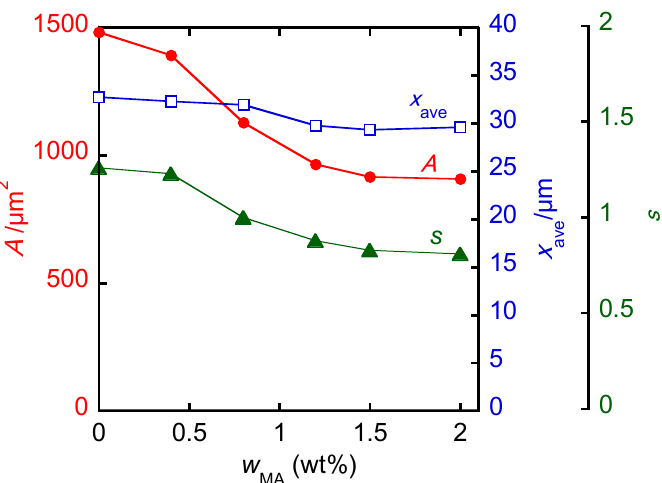
Figure 14. Plot of characteristic values obtained by image analysis of the cut surface for the w MA value of MAPP added to the MCC/MAPP/PP ternary composites (weight ratio, 22.5/2.5/75). For convenience, the data for the MCC/PP composite without MAPP are shown at w MA = 0. Reprinted with some modifications from Ref. [42]. Copyright Elsevier Ltd. (2020).